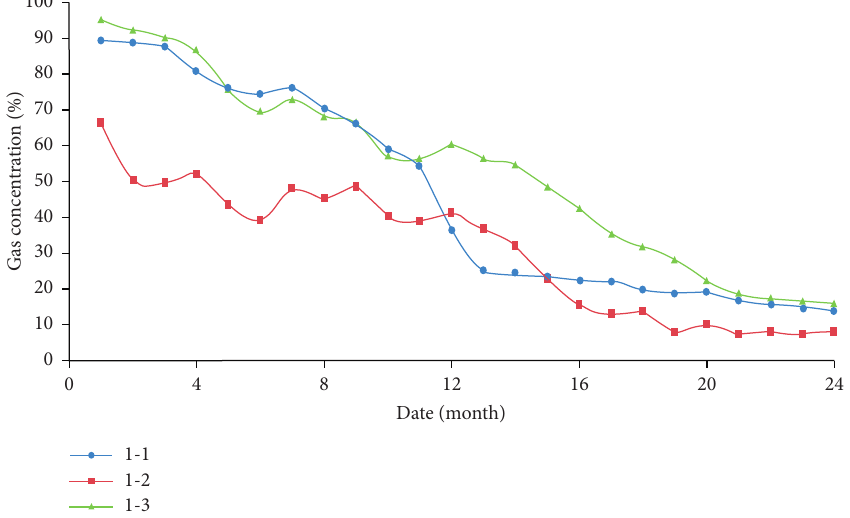
Figure 13: Concentration of borehole gas in No. 1 drilling